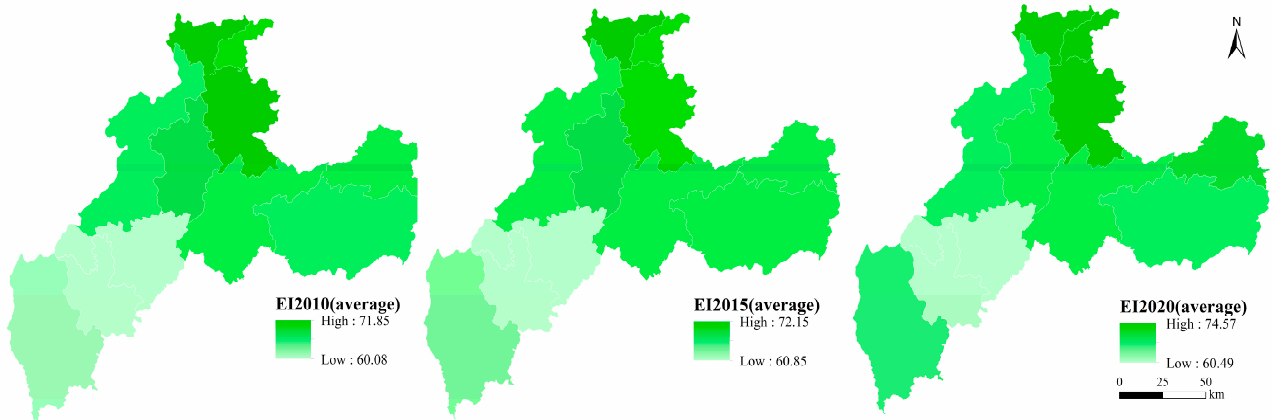
three periods was similar. Specifically, the average EI values of northern Zhaotong were high, especially in Yanjin and Suijiang counties. However, Zhaoyang district and Ludian county had low average EI values. From the perspective of spatiality, average EI values presented the pattern of high values in the north and low values in the south. From the standpoint of the highest–lowest value, from 2010 to 2020, the lowest values were 60.08, 60.85, and 60.49, respectively, while the highest values were 71.85, 72.15, and 74.57. Generally, the lowest value showed a fluctuating upward trend, with the value increas- ing by 0.69%. The highest value showed an increasing upward trend with the value in- creased by 3.78%. These results indicated that the EEQ of Zhaotong improved from 2010 to 2020, which was consistent with the results of the ECEI. In addition, based on the technique criteria, all years’ highest and lowest EI values were higher than 55, indicating that all regions of Zhaotong city qualified for good grades. To further validate the accuracy of the ECEI, average ECEI and RSEI values of the same three periods were calculated to draw the scatter diagram and establish the fitting curve (Figure 11).